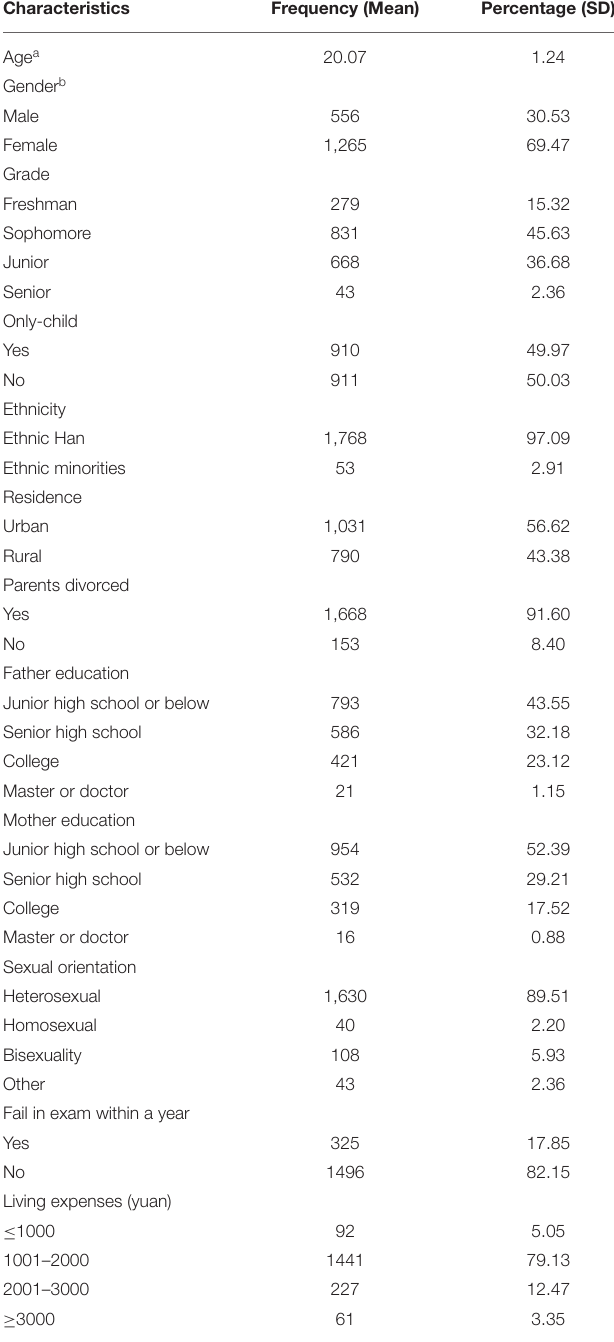
TABLE 1 | Sociodemographic characteristics of undergraduate students ( n =